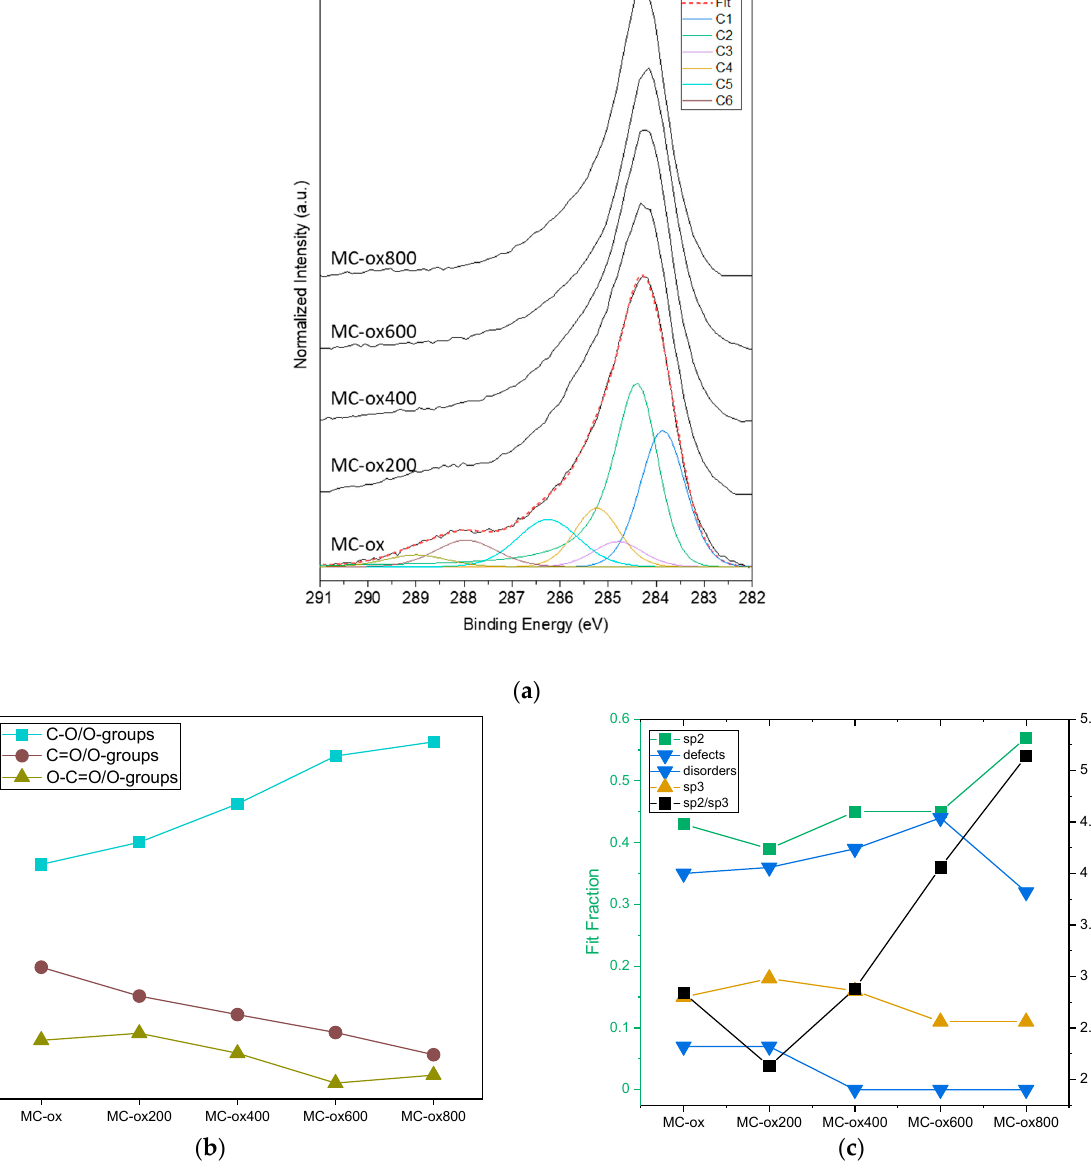
Figure 6. XPS analysis of the functionalized MC samples. ( a ) C1s spectra showing the peak deconvo- lution where defects (C1), graphitic sp 2 (C2), disordered carbon (C3), sp 3 (C4), C–O (C5), C=O (C6), O–C=O (C7) are considered in the fitting model (red dashed line shows the fit); ( b ) relative change in the composition of oxygen groups with increasing annealing temperature; ( c ) relative change in the composition of graphitic-sp 2 , defects, disordered, and sp 3 carbon ( (cid:4) represent the change in the ratio of graphitic-sp 2 /sp 3 as a function of annealing